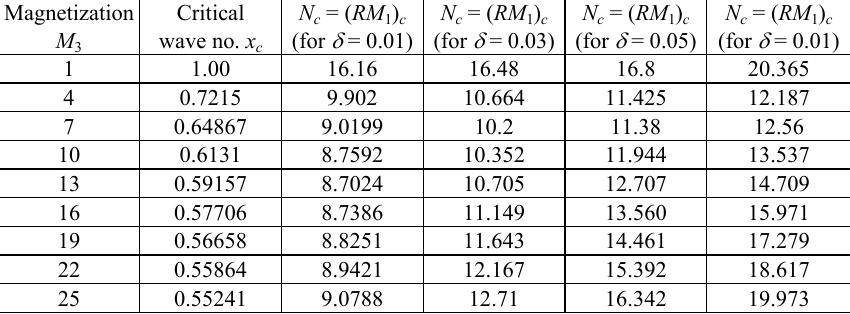
Table 3. Critical magnetic thermal Rayleigh numbers and wave